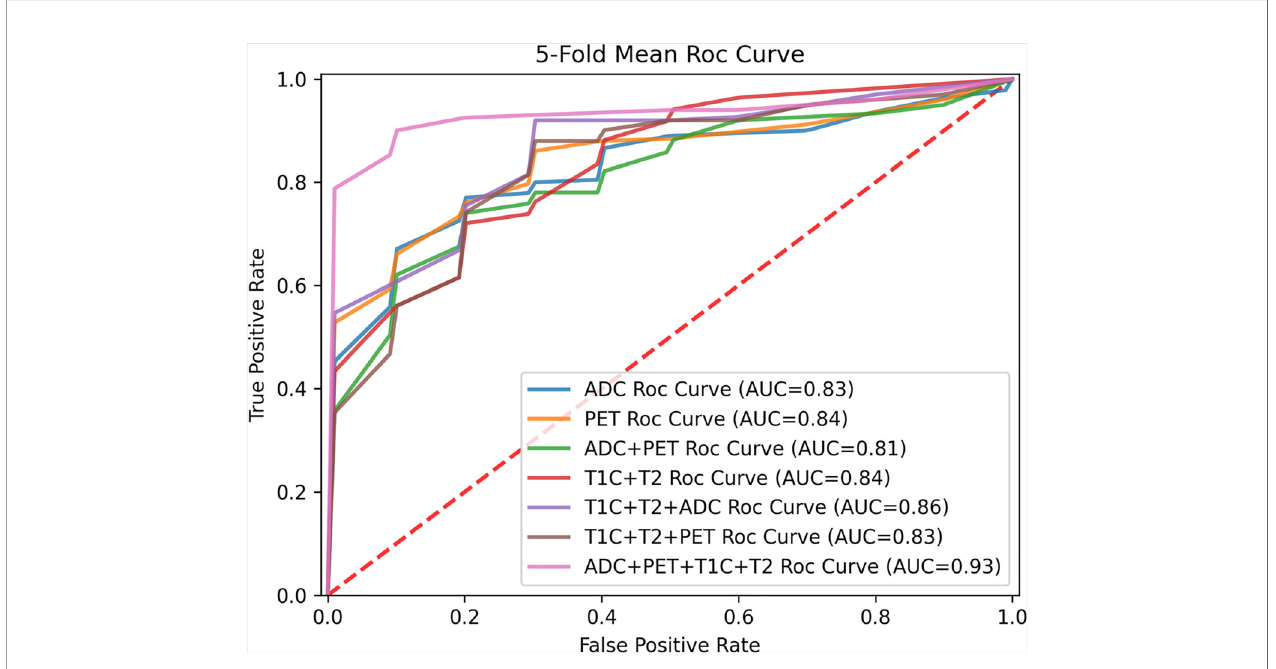
FIGURE 6 | Fivefold mean ROC curve for different modality combination.